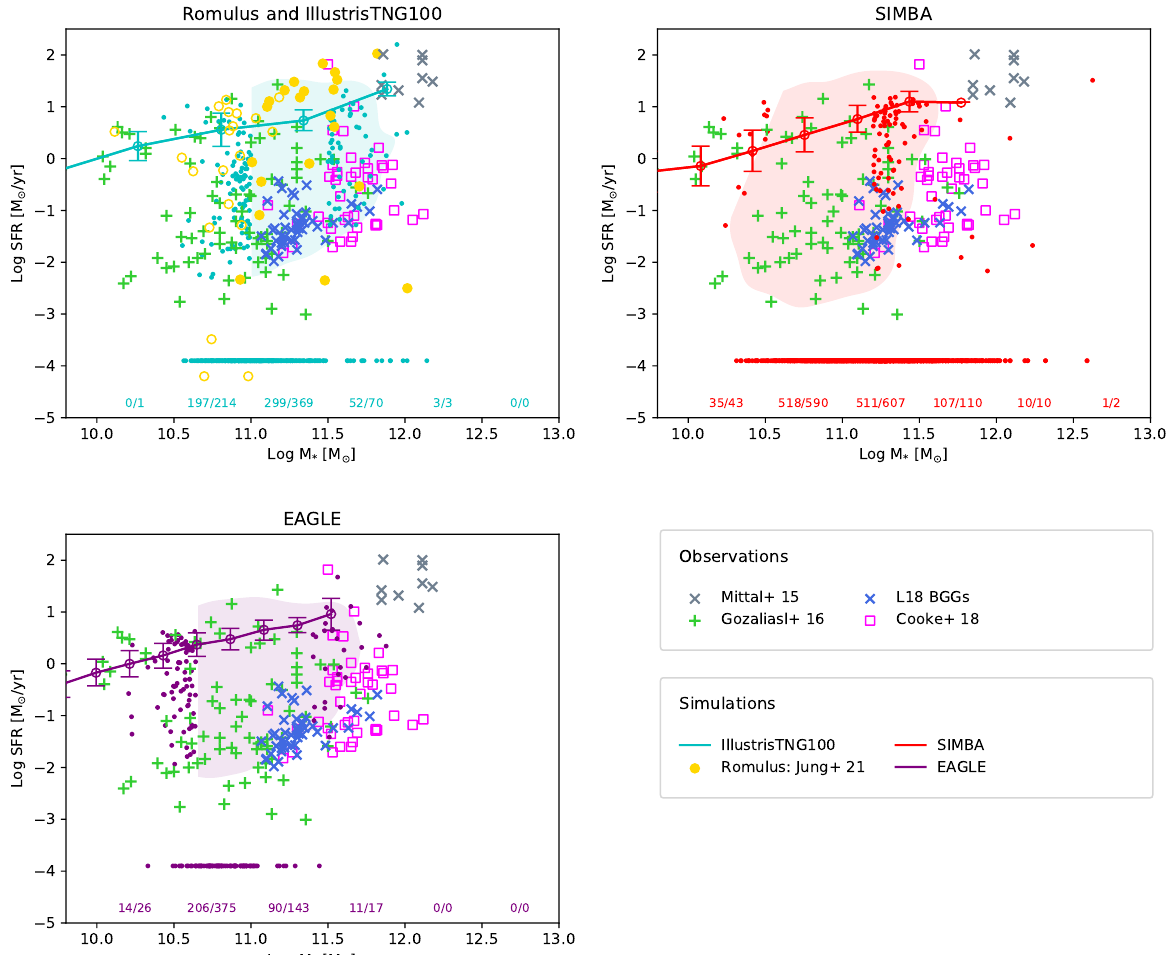
Figure 9. Figure adapted from Jung et al. [73]: Comparison of the z = 0 star formation rate (SFR)- M (cid:63) relationship for observed and simulated BGGs and BCGs. Arranged as Figure 8, each panel plots the same four sets of observational results (see text for details). The top left panel shows the results for ROMULUS (yellow filled and open circles; filled circles represent systems we identify as groups/clusters) and TNG100 simulations (cyan); the top right panel shows the results for SIMBA (red); and the bottom left panel shows the results for EAGLE (purple). The simulation SFRs are extracted from a sphere of radius 30 pkpc encompassing the central BGG/BCG while the stellar masses as the same as in Figure 8. The line connecting the open circles with error bars shows the star forming main sequence (SFMS) for TNG100, SIMBA, and EAGLE from Davé et al. [154]. The shaded regions, and the handful of individual points to the left and right, show where the simulation BGGs/BCGs with measurable SFR lie on this plot. BGGs/BCGs with unresolved/too low SFRs are assigned log ( SFR/M yr − 1 ) = 4 and plotted accordingly. We identify all simulation BGGs/BCGs with SFRs (cid:38) 0.75 dex below the − (cid:12) observed z < 0.5 SFMS of Whitaker et al. [262] as “quenched”. For TNG100, SIMBA, and EAGLE, we specify the fraction of quenched galaxies in 0.5 dex M bins at the bottom of the panels. We do not differentiate between quenched systems ∗ with low but measurable SFRs and those with very low/unresolved SFRs. Measuring very low SFRs using observationally accessible diagnostics is extremely challenging; strictly speaking, the corresponding published SFRs ought to be treated as upper